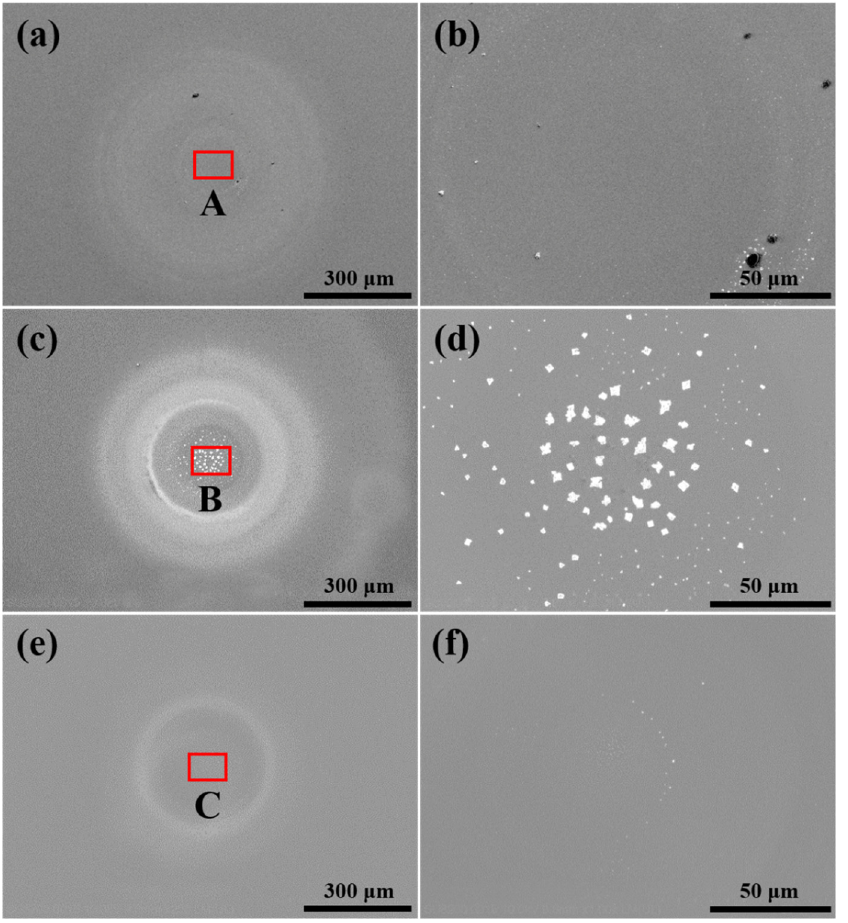
Figure 7. Typical damage morphologies of the films. ( a ) 293 K, ( b ) Enlarged Position A, ( c ) 423 K, ( d ) Enlarged Position B, ( e ) 523 K, and ( f ) Enlarged Position C.